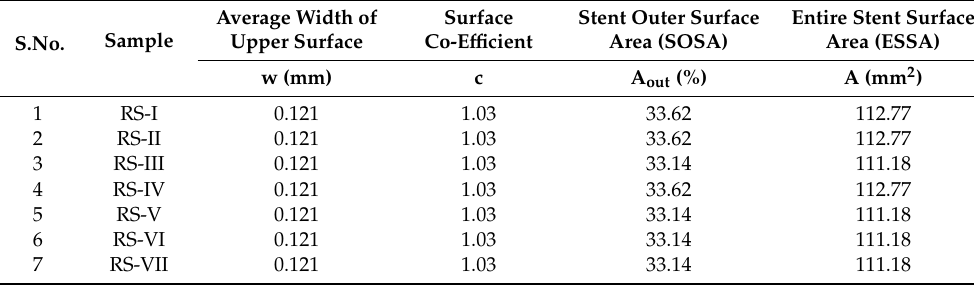
Table 1. Surface area calculation using the developed model.